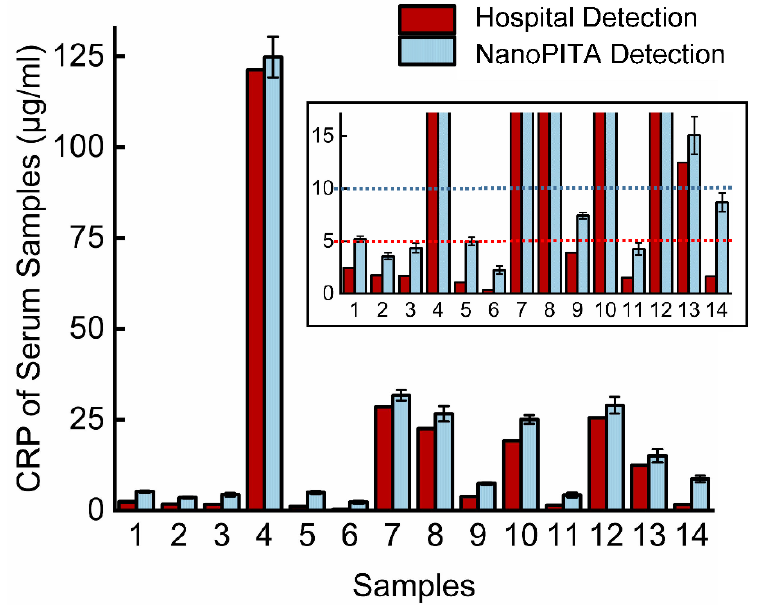
Figure 6. Measurement of CPR with different blood serum samples by the NanoPITA method in the lab and latex agglutination in the hospital. The figure on the upper right is a close-up view of the low concentration, where the red and blue dotted lines represent 5 μg/mL and 5 μg/mL, respectively.